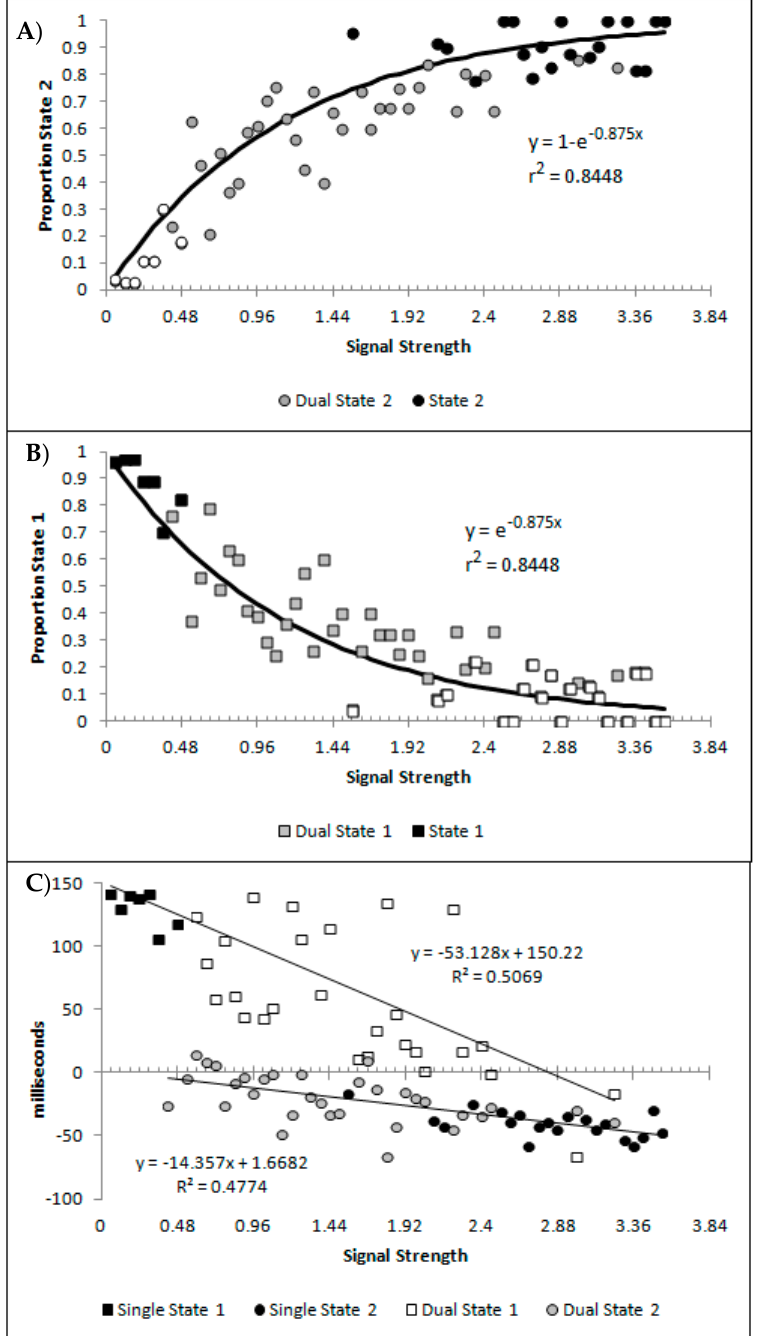
Figure 10. Shown as a function of signal strength, are A ) the estimated proportions of state 1 responses B ) the estimated proportions of state 2 responses and C ) the estimated mean response time of the state 1 and state 2 distributions.